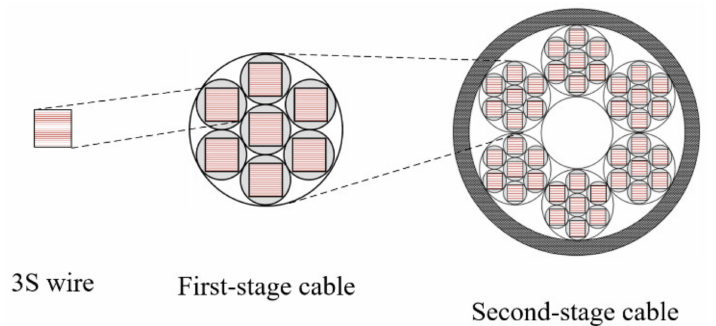
Figure 1. Conceptual illustration of multistage cable structure using 3S wires.